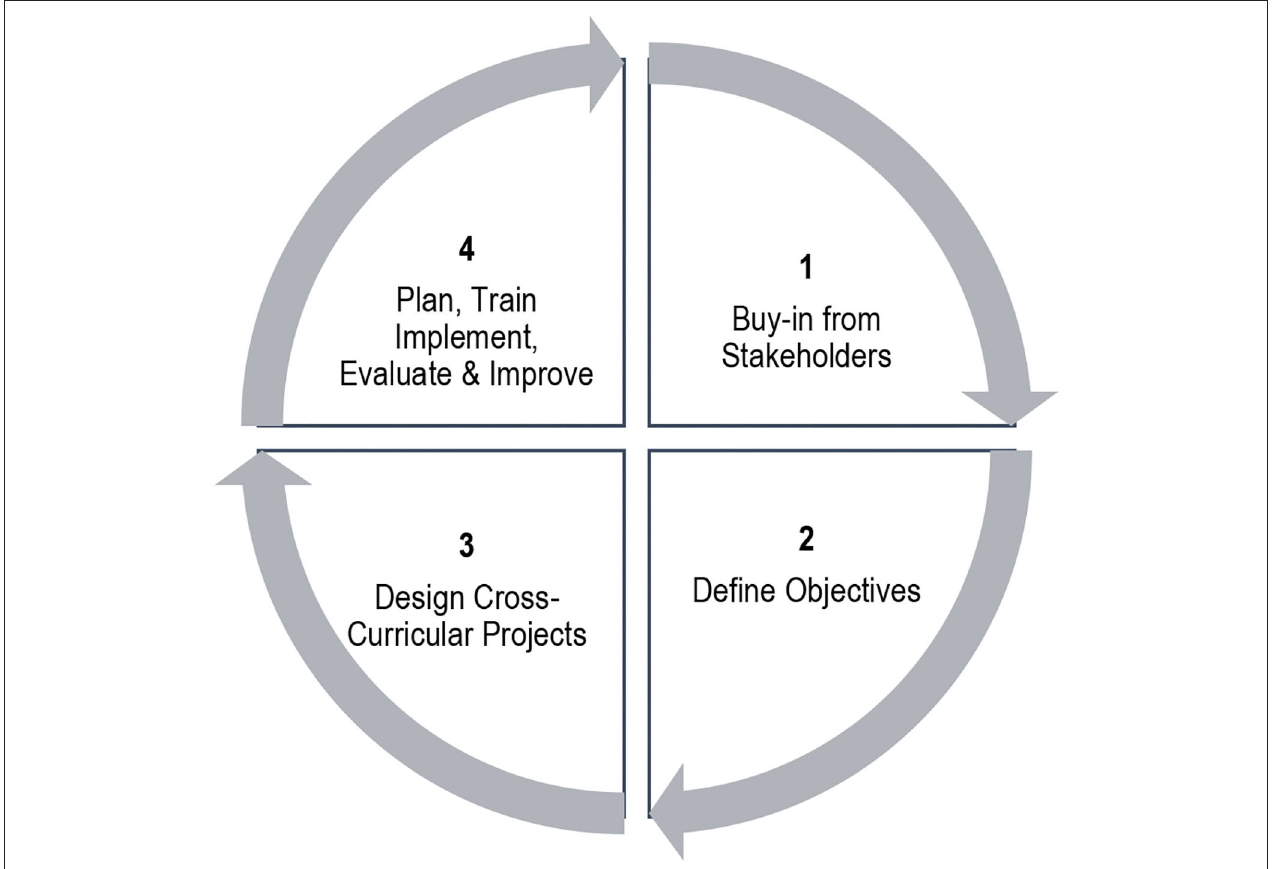
FIGURE 2 | Framework to initiate University Wellness